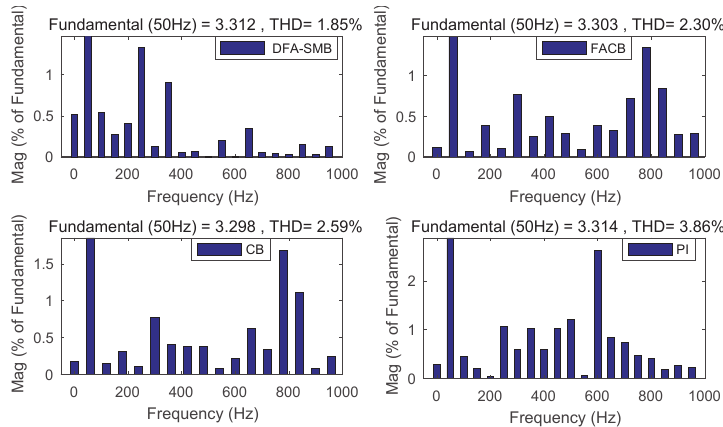
Figure 11. Total harmonic distortion (THD) analysis of PV system output current under different